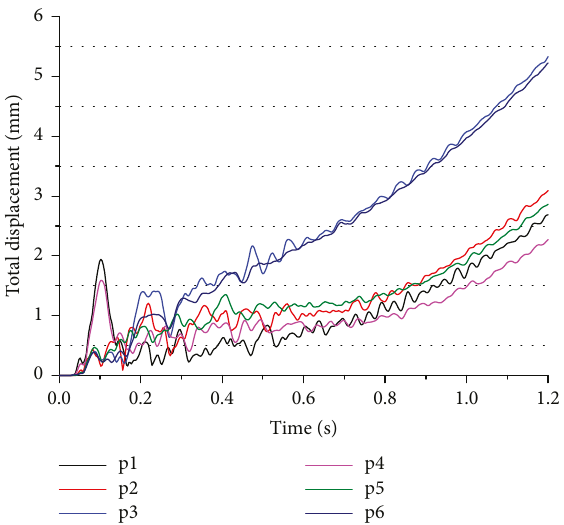
Figure 35: Time-history response curve of resultant displacement at characteristic points on the embankment in the second excavation.